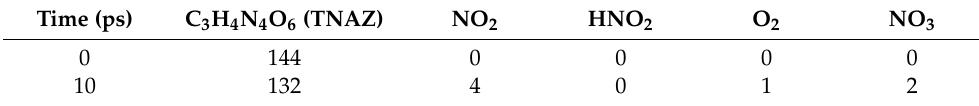
Table 3. Number of TNAZ molecules and other small molecules in the [001] direction.